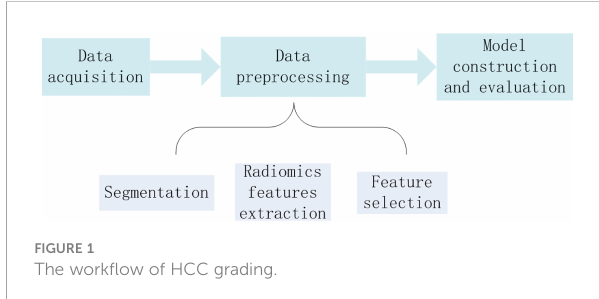
FIGURE 1 The work fl ow of HCC